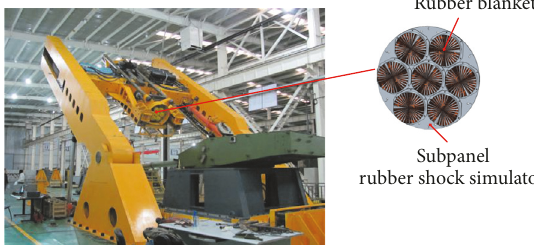
Figure 2: Shock simulation tester with rubber shock simulator.